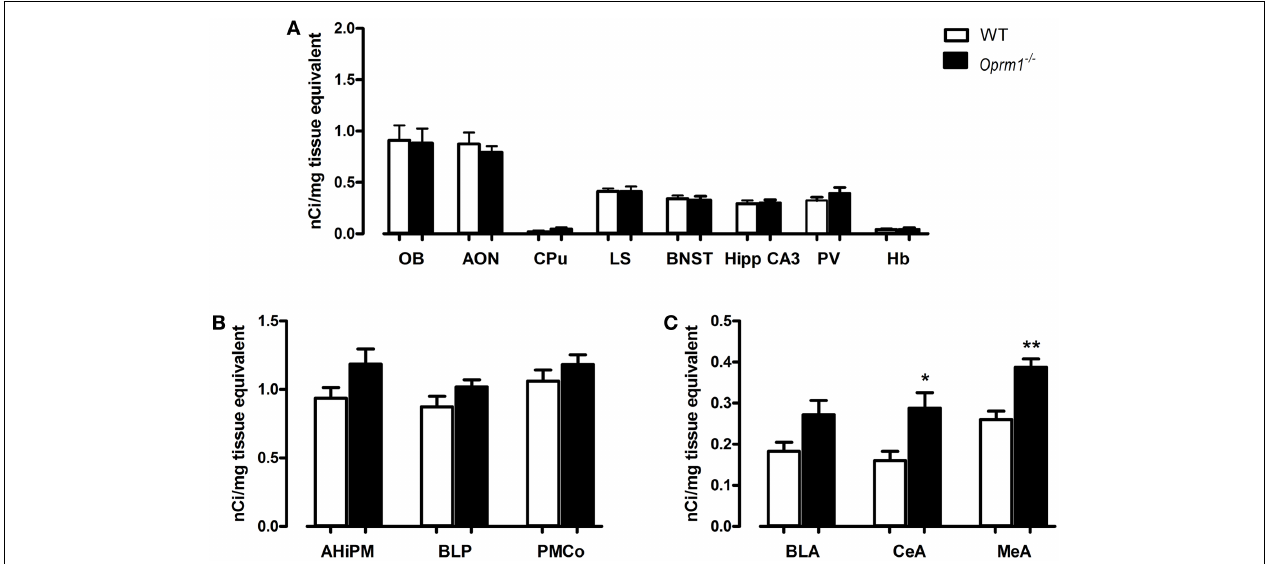
MOR and OXTR. (B) OXTR expression is not influenced by the lack of MOR in the posterior nuclei of the amygdala whereas (C) an increase of OXTR is detectable in the anterior nuclei of the amygdala CeA and MeA. Data expressed as mean and SEM of three to four animals. * p < 0.05, ** p < 0.01 compared toWT